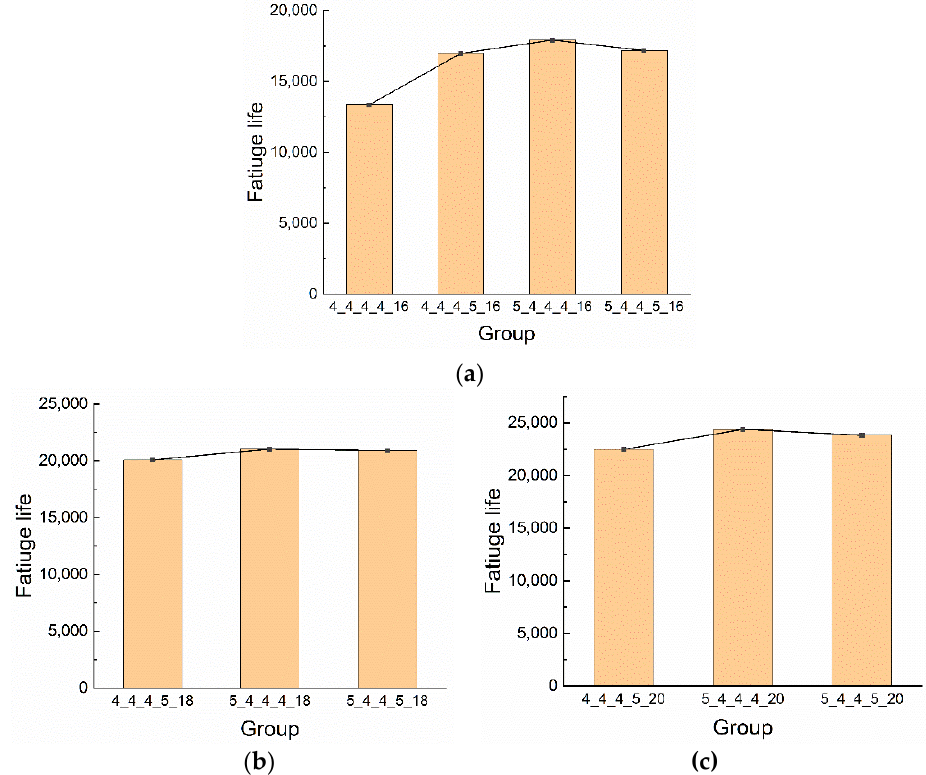
Figure 20. The fatigue lives of riveted lap joints with different rivet diameters: ( a ) Rivet pitch is 16 mm; ( b ) rivet pitch is 18 mm; ( c ) rivet pitch is 20 mm.